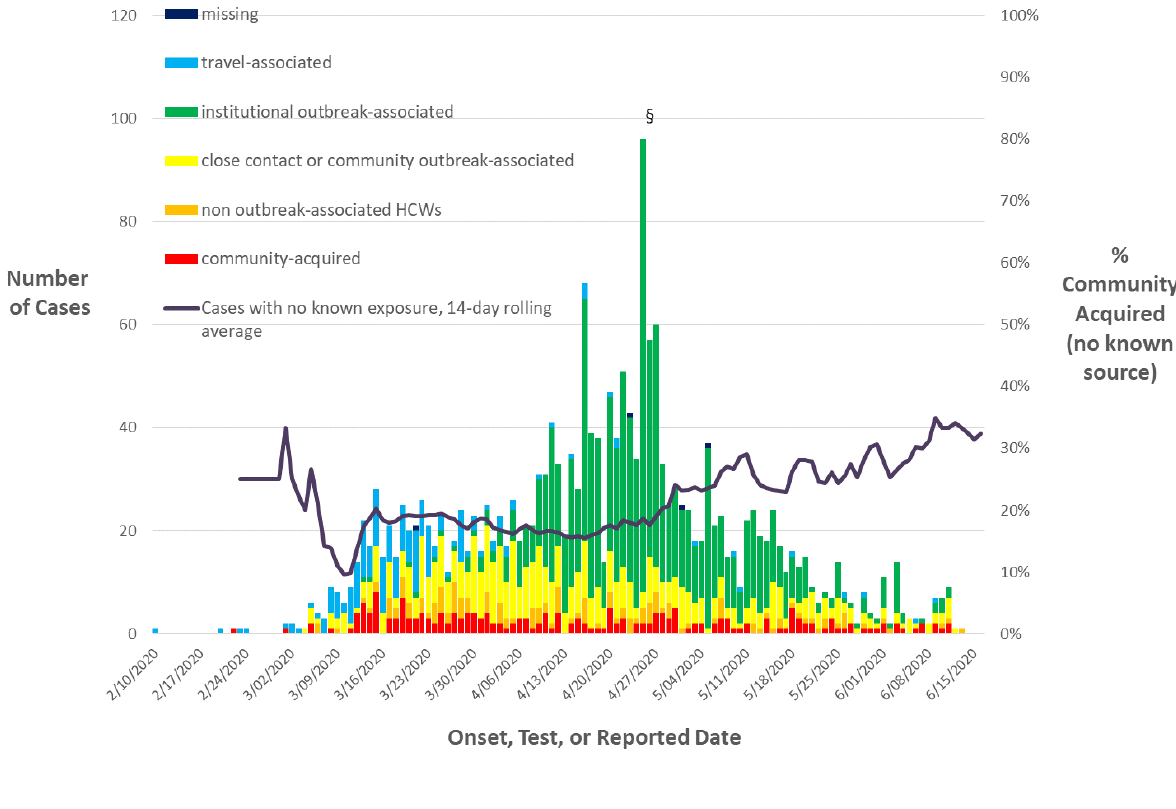
Figure 2: Epidemiological curve of Ottawa residents with confirmed COVID-19, by the earliest of onset, test and reported date, by source of infection